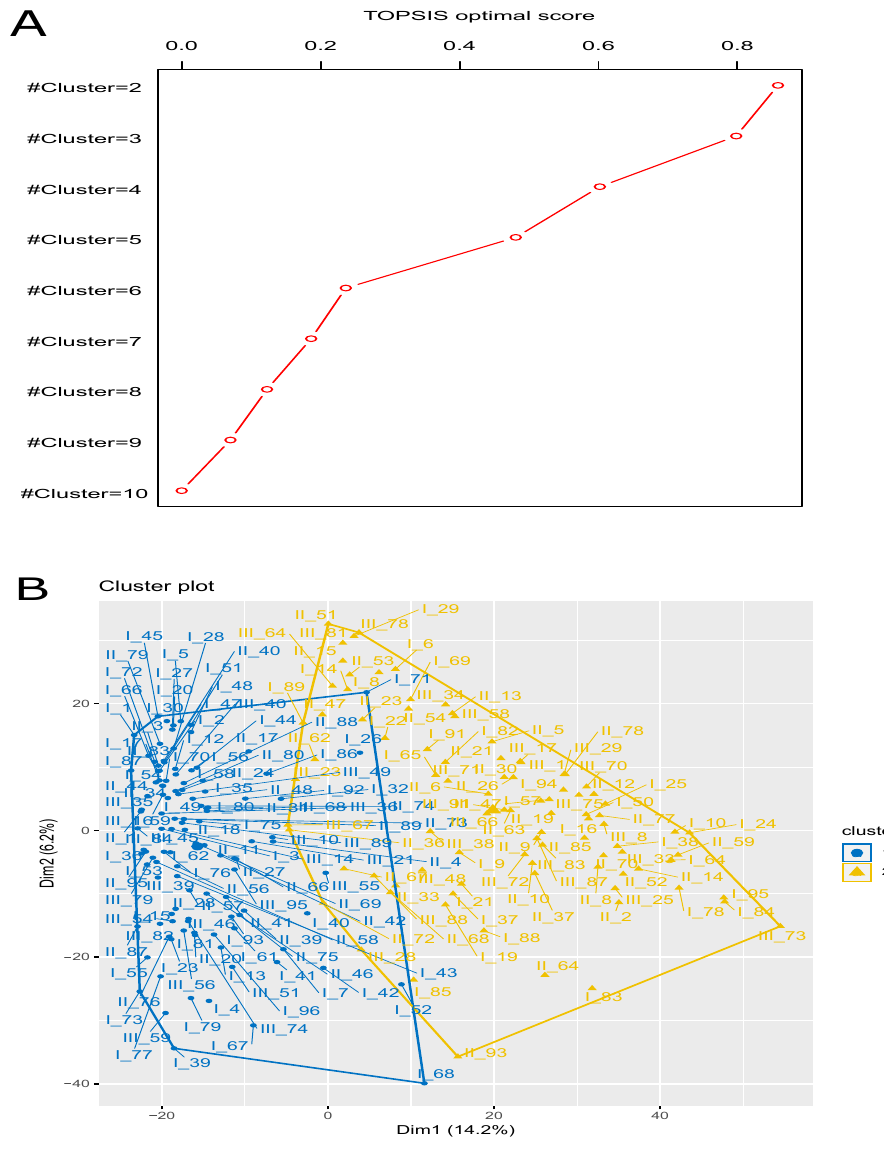
Figure 3. Plots for multi-objective optimization and Principal Component Analysis (PCA). ( A ) Multi-objective optimization (TOPSIS) score for different cluster sizes (nine case studies: cl = 2,3,...,10) using Fuzzy c-means clustering. ( B ) The cluster plot (PCA plot) of the optimized fuzzy clustering along with their participating